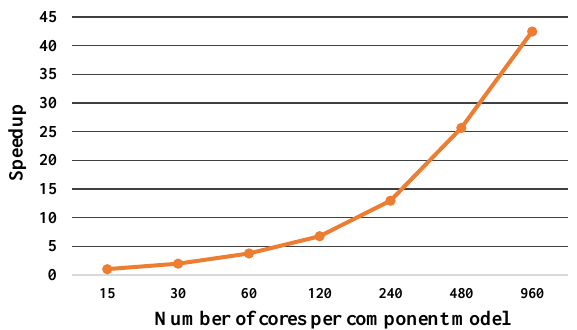
Figure 13. The parallel speedup of dynamic 3-D coupling (for 100 ping-pong couplings) between the two component models, with a new configuration derived from the configuration used in Fig. 8. The speedup is normalized to the time at 15 cores per component model